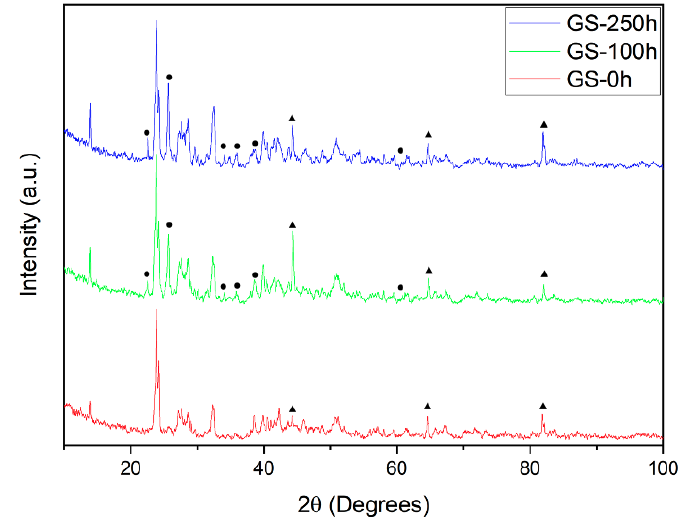
Figure 4. Diffraction profiles of samples after sintering (red), aged for 100 h (green) and for 250 h (blue). Peaks not related to the Ba 3 Si 2 O 8 phase are indicated in the spectra with ( ▴) for the Fe-Cr alloy and ( ⦁) for MgCrO 4 .